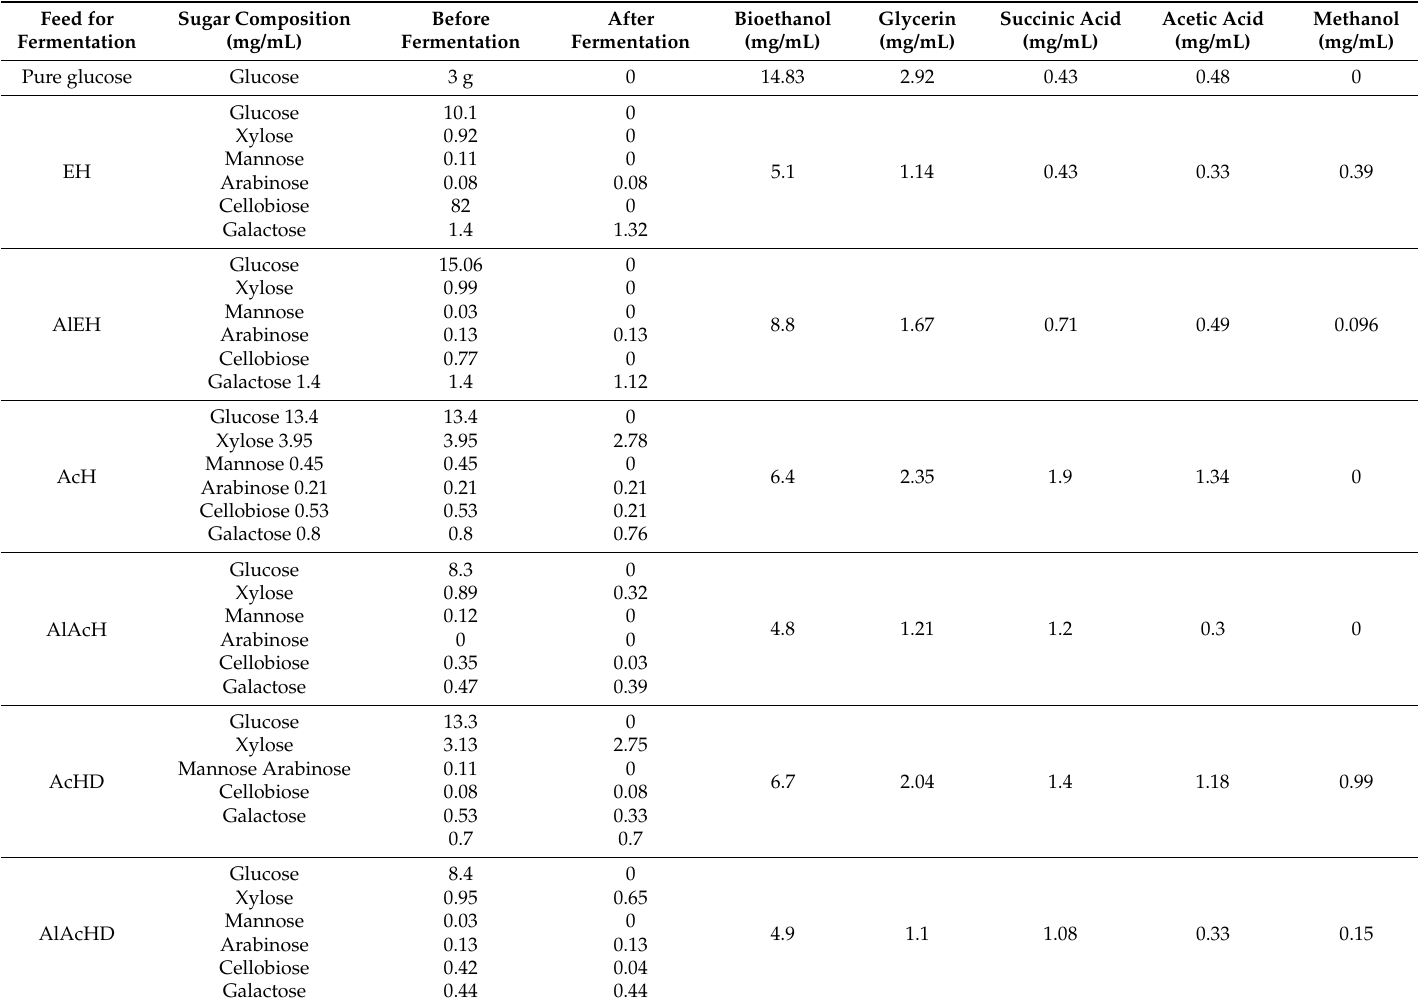
Table 8. Sugar content in hydrolysates and composition of fermentation